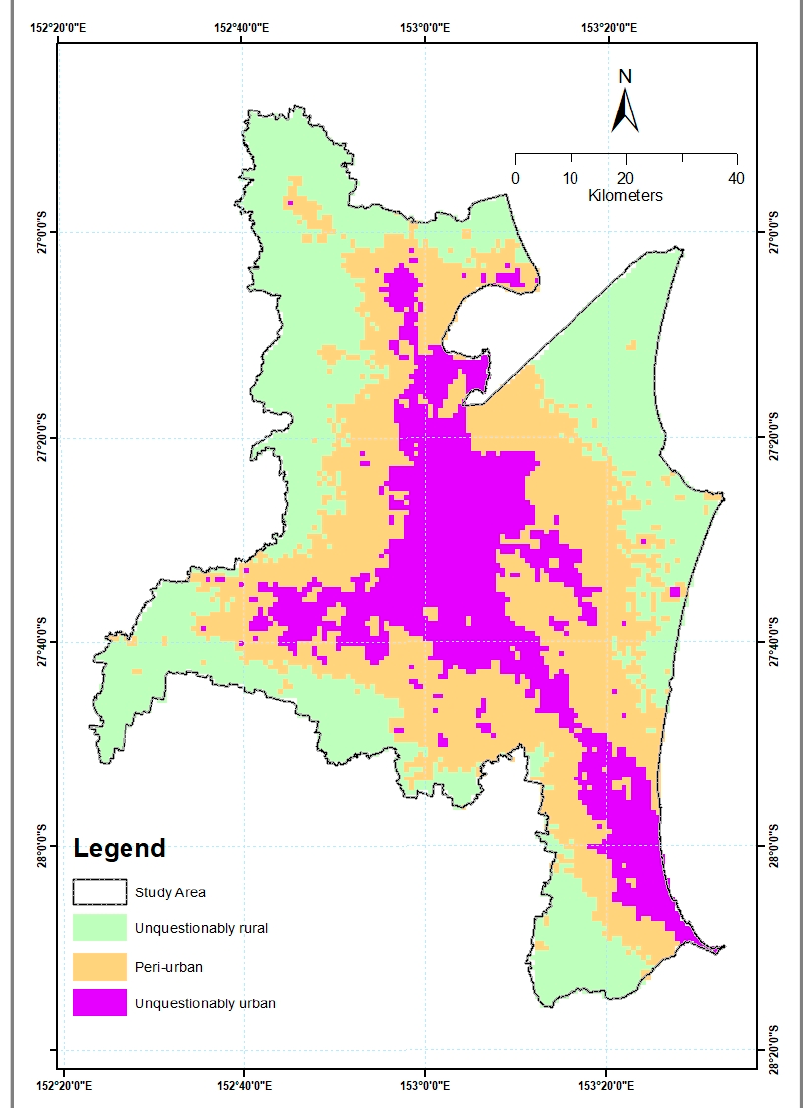
Figure 2. Mapping peri-urban areas of 2019 by fuzzy logic on night-time light (NTL) data.